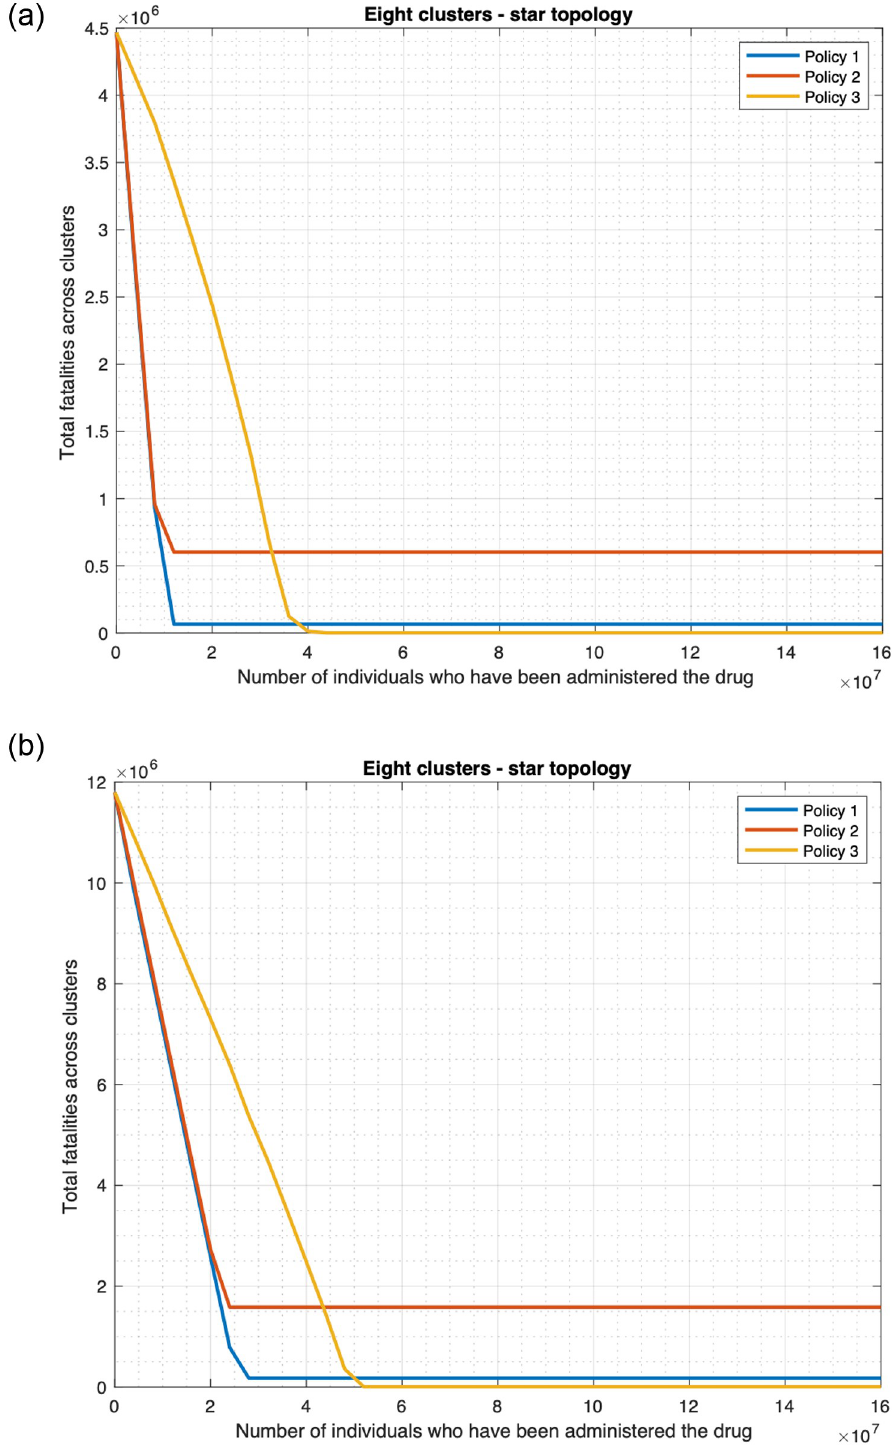
Fig 17. Policies for drug deployment (star topology). (a) Initially infected individuals are in the central cluster. (b) Initially infected individuals are distributed uniformly across clusters.